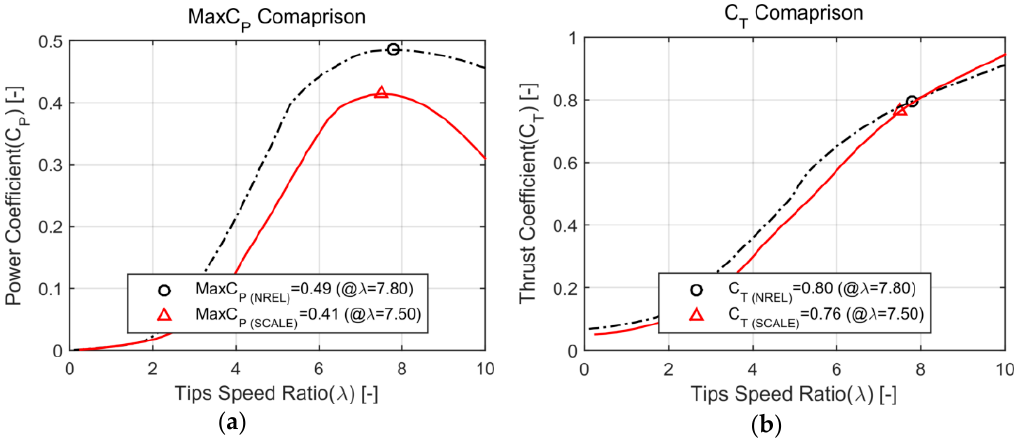
Figure 2. Aerodynamic coefficients of the scaled model and National Renewable Energy Laboratory (NREL) 5 MW wind turbine: ( a ) power coefficient vs. tip speed ratio, and ( b ) thrust coefficient vs. tip speed ratio. Table 1. Specifications of the wind turbine scale model.